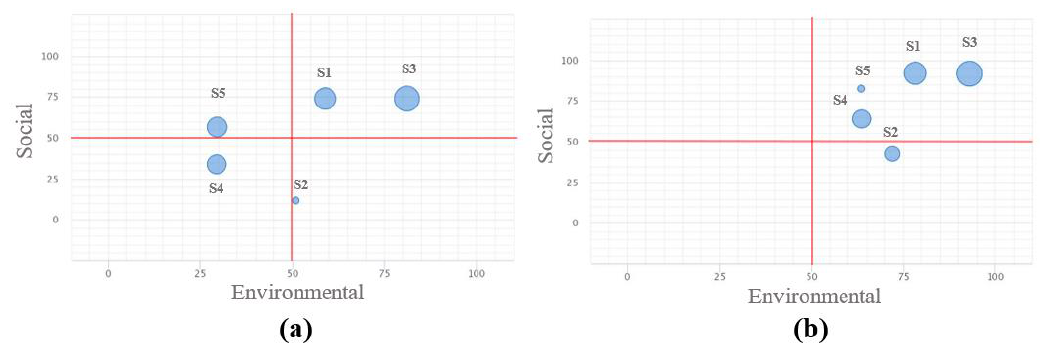
Figure 7. Supplier segmentation by social vs. environmental analysis. ( a ) PROMETHEE. ( b ) MAUT.